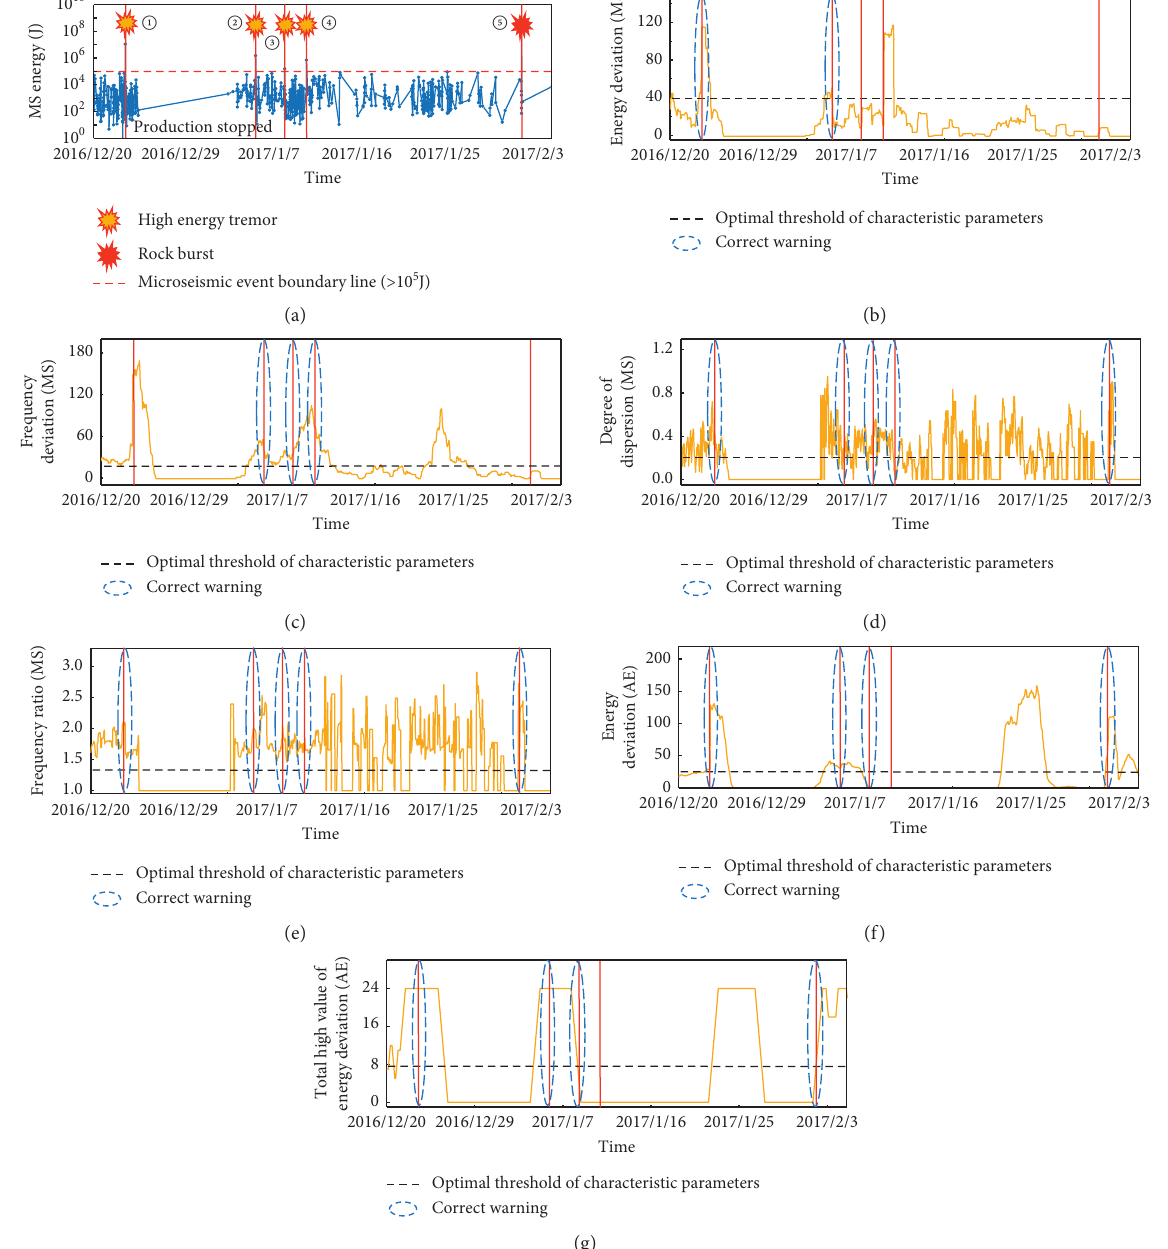
Figure 8: The time series curve of each precursory characteristic parameters, (a) energy of MS event; (b) time series curve of D system; (c) time series curve of D F of MS system; (d) time series curve of D S of MS system; (e) time series curve of F r of MS system; (f) time series curve of D E of AE system; (g) time series curve of D H of AE system ① 2016/12/23 5 :50: 37, 1.10 E +07J; ② 2017/1/5 14: 45:25, 1.50 E +06J; ③ 2017/1/8 14: 23:01, 1.60 E +05J; ④ 2017/1/10 20: 07:07, 7.10 E +05J; ⑤ 2017/2/1 21: 51 :21, 2.10 E